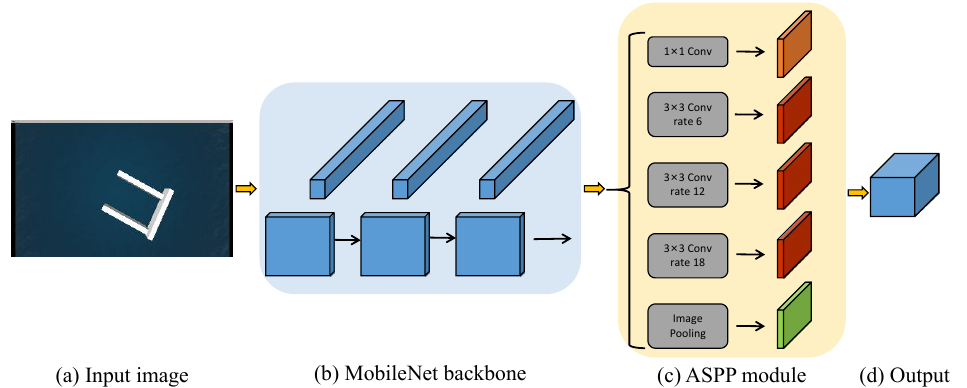
Figure 3. The network architecture of the semantic segmentation algorithm deployed on the